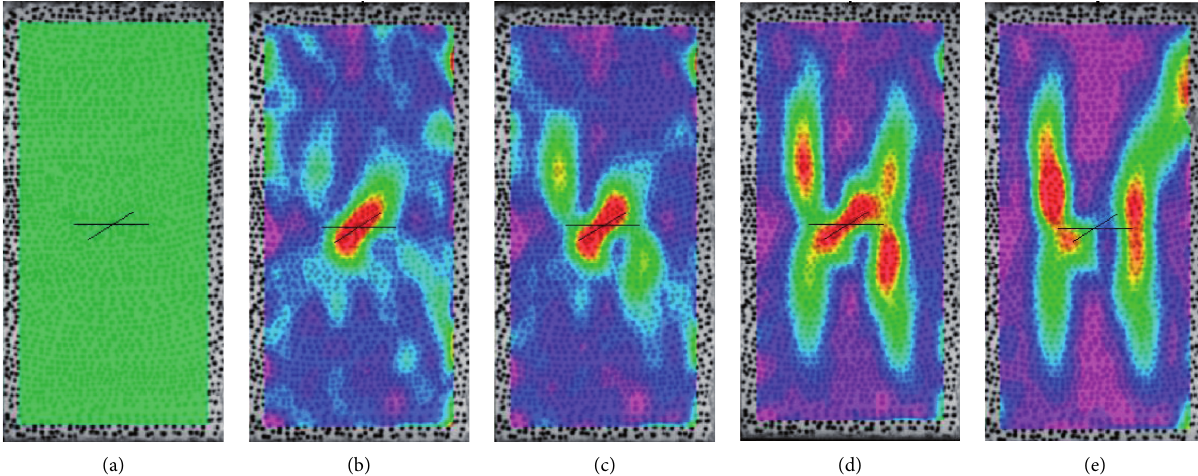
Figure 10: Stress field developed at different times for the jointed specimen with α � 30 ° . (a) t � 0s. (b) t � 315s. (c) t � 500s. (d) t � 620s. (e) t �